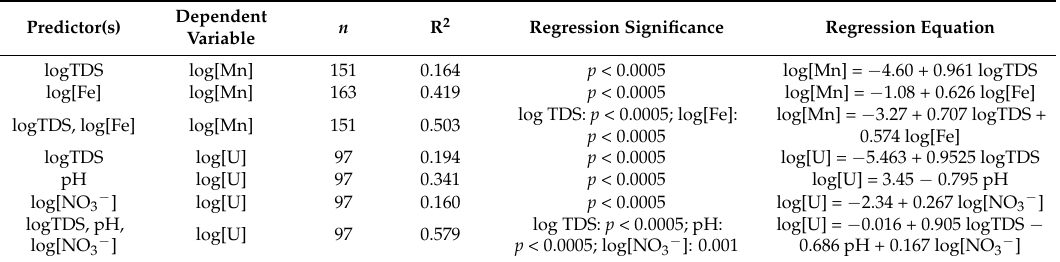
Table 6. Predictors of [Mn] and [U] in Crow Reservation well water.